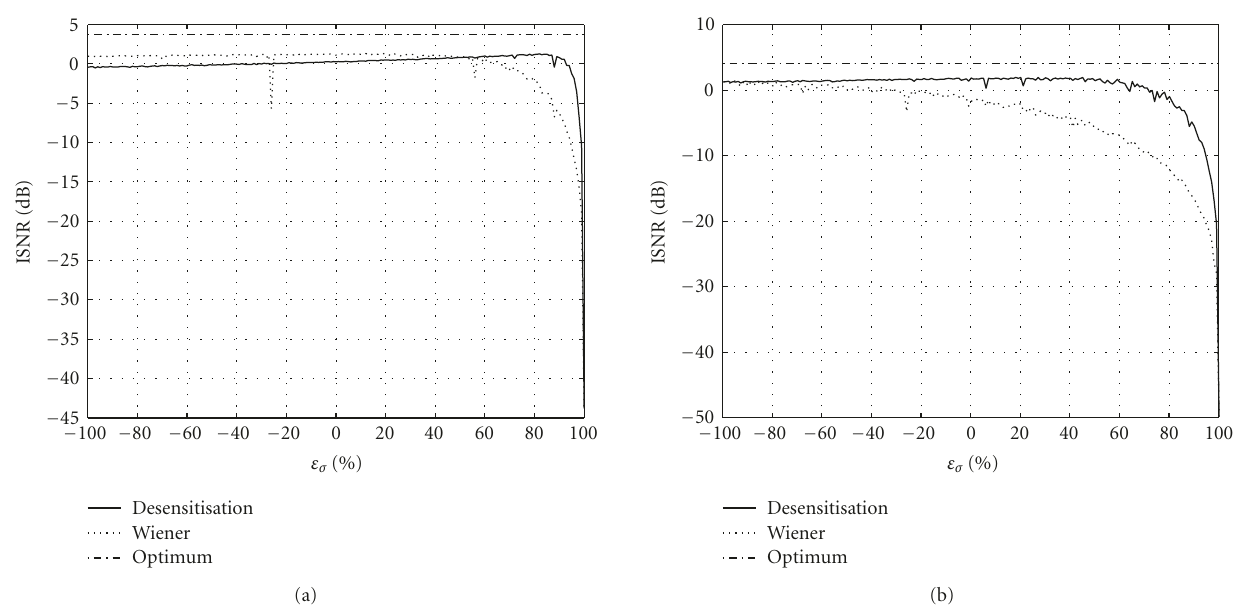
Figure 10: Distributions of ISNR obtained by both the Wiener filter and our desensitised method when a Gaussian noise is estimated according to a BSNR of 10dB whose variance is altered by ε σ while a multiplicative noise (a) and a “salt and pepper” artefact (b) are added to the original image. Regarding PSF, the estimated parameter keeps unchanged. Besides, a horizontal line is included symbolizing the constant value of ISNR reached when optimum estimates are considered in the Wiener